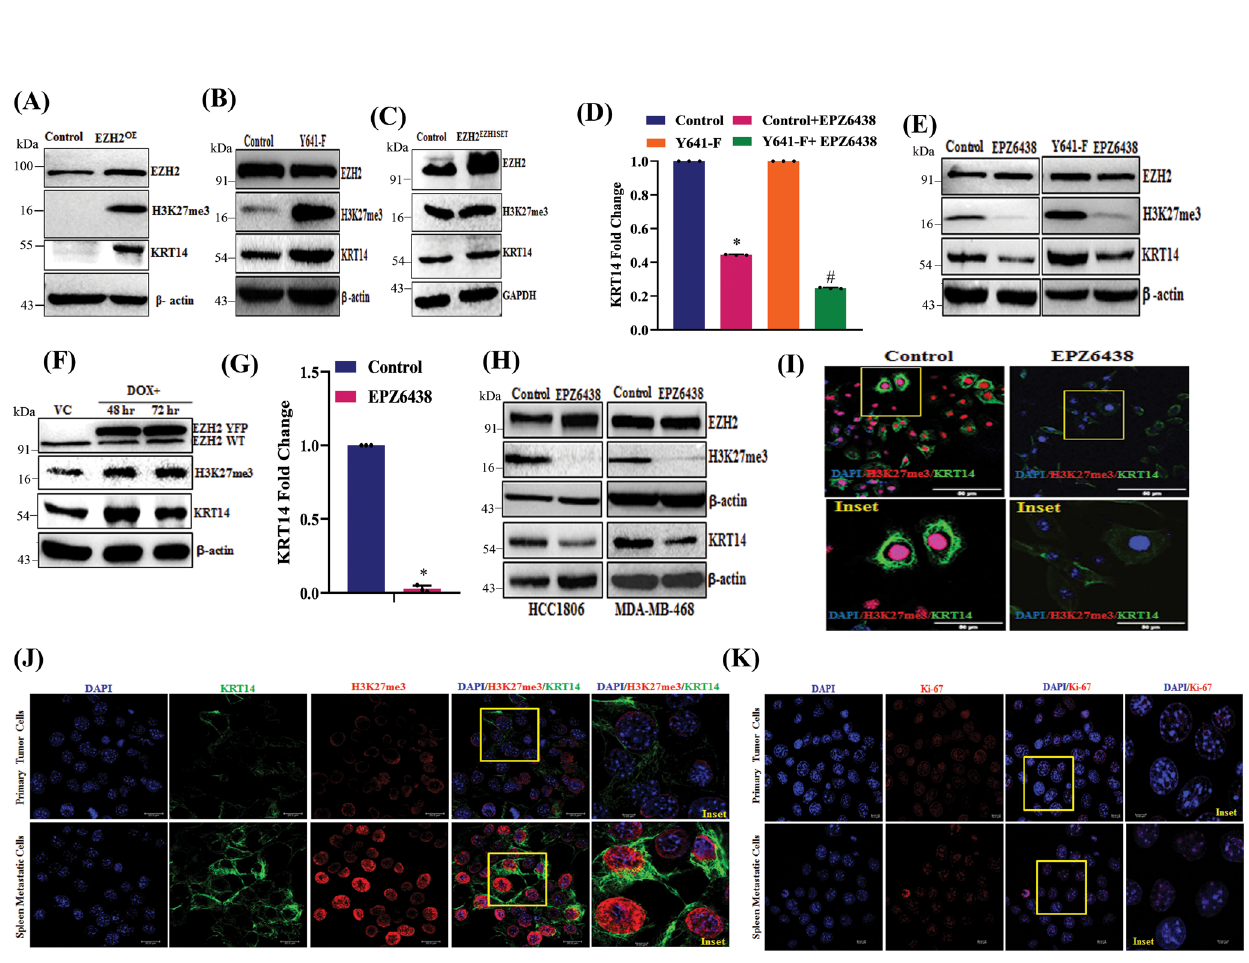
Fig. 4 | H3K27me3 level positively regulates the expression of KRT14 in mRNA andproteinlevels.A ImmunoblotanalysisforEZH2,H3K27me3, β -actinincontrol, and EZH2 OE HCC1806 cells. B Control and EZH2 Y641-F cells were analyzed for expressionofEZH2,H3K27me3,KRT14,and β -actinbyImmunoblot. C